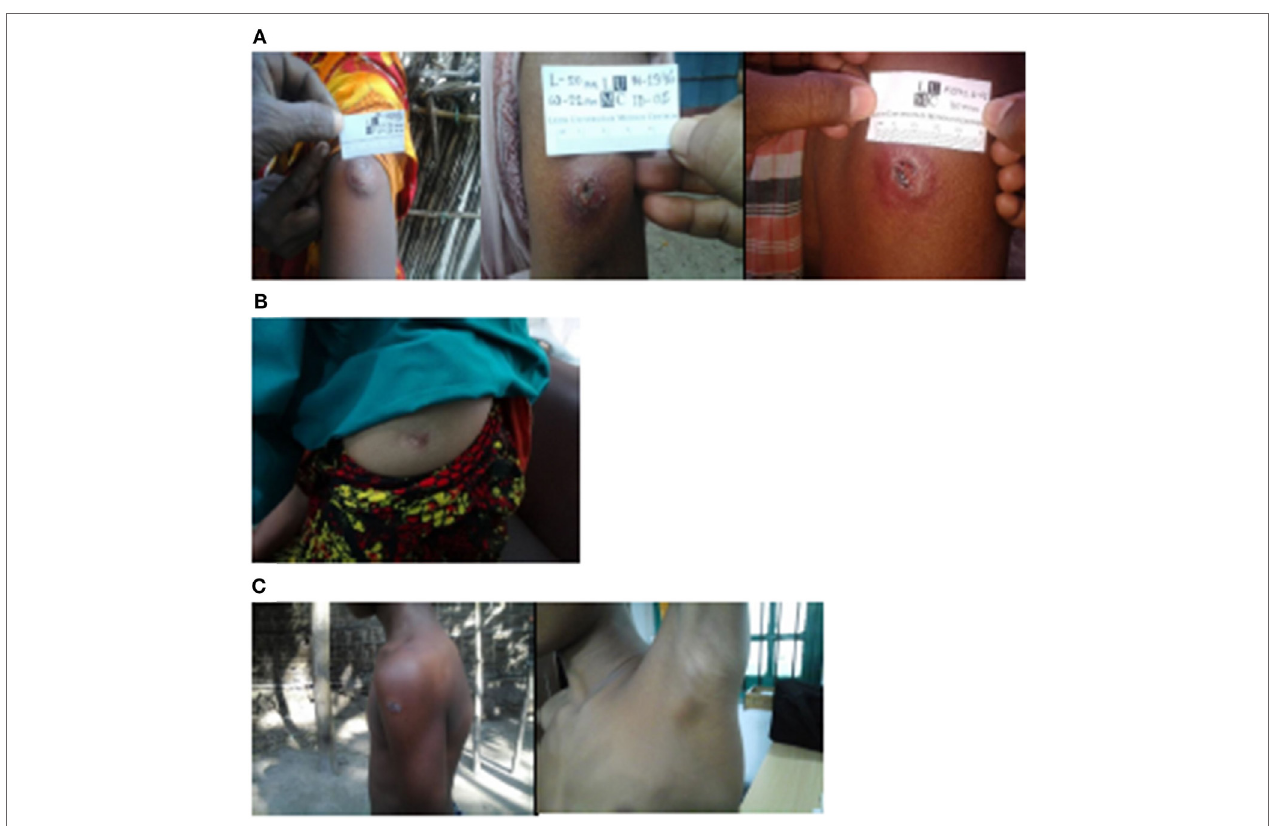
FiGUrE 1 | Representative examples of skin complications after BCG vaccination. (a) Three contacts with big ulcers ( > 10 mm). (B) A contact with keloid (picture taken before operation). (C) A contact with an ulcer and lymphadenitis who developed leprosy at